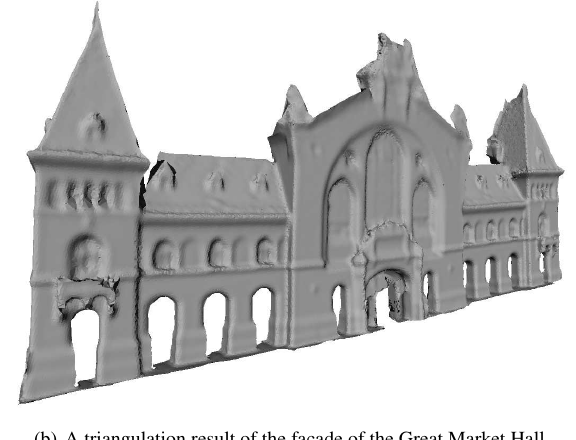
Figure 4: Sample results on facade approximation based on RMB Lidar data with the proposed approach